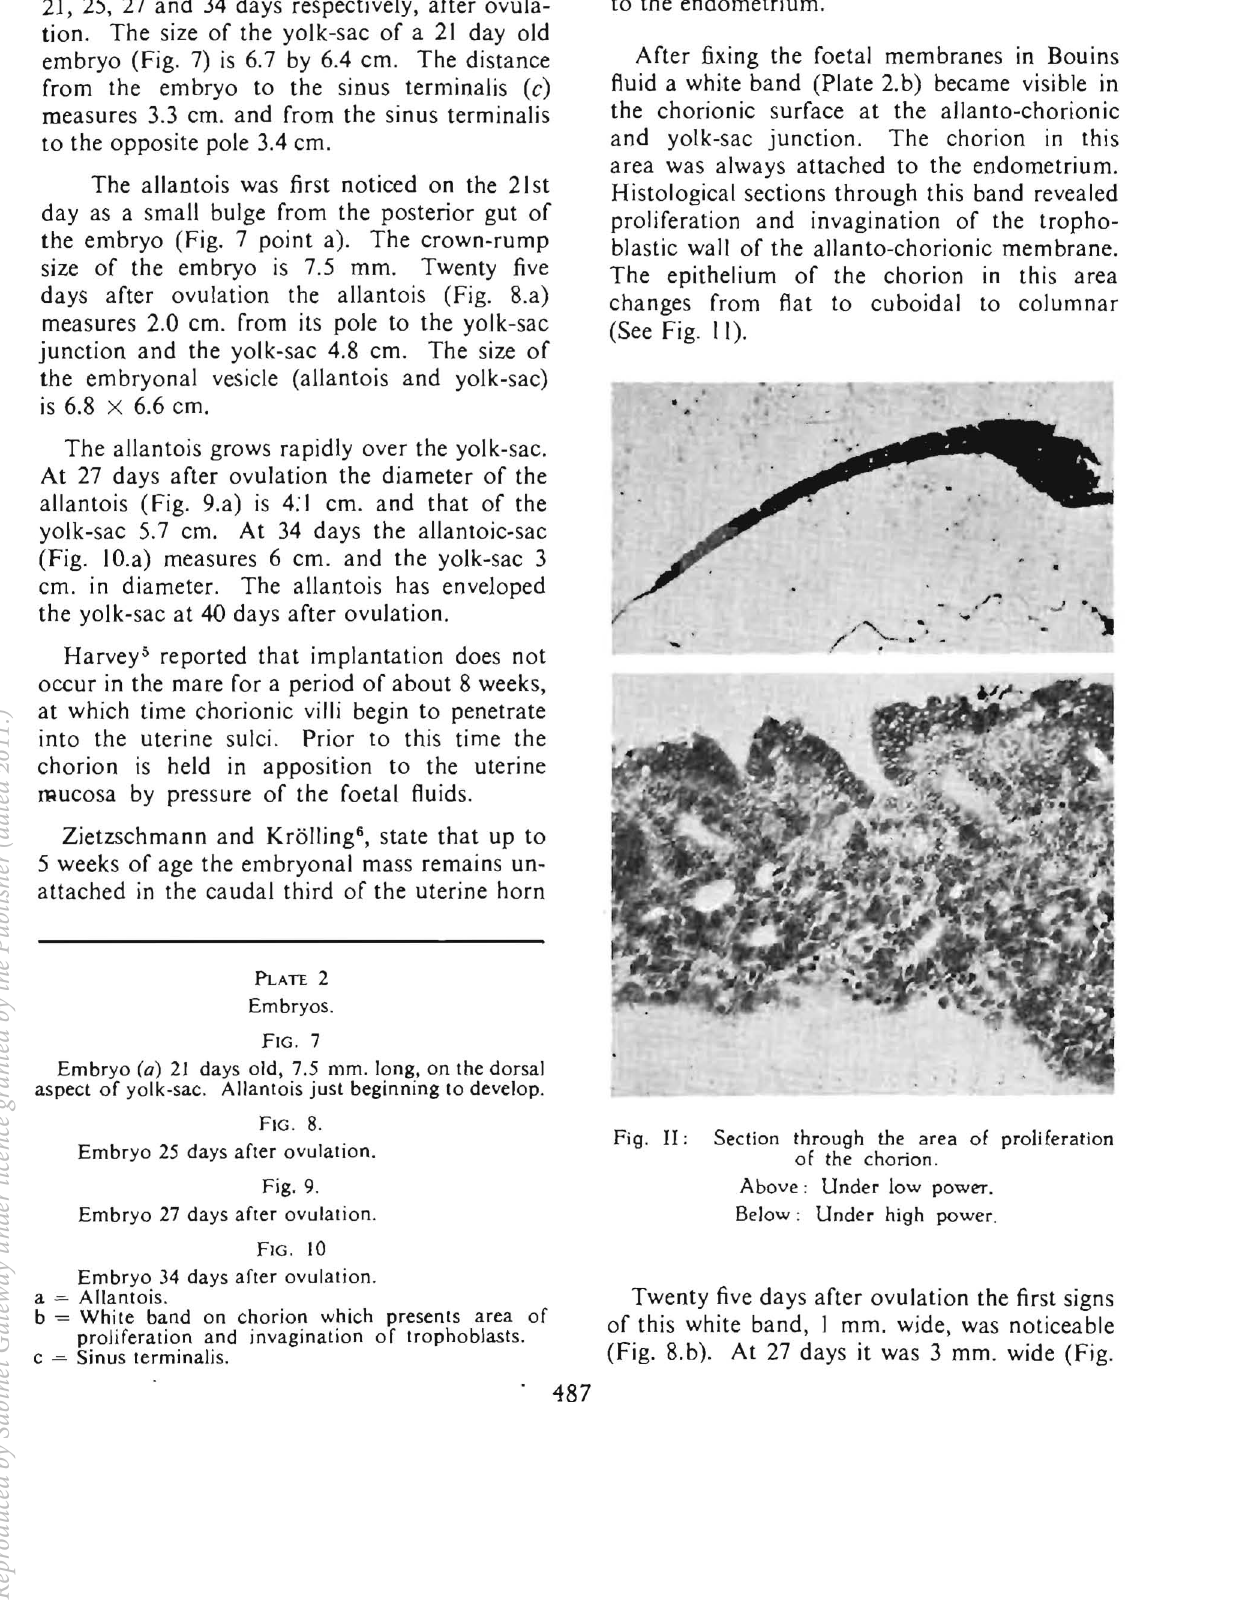
Embryo 25 days after ovulation. Embryo 27 days afrer ovulation. Embryo 34 days after ovulation. a = Allanrois. b = White band on chorion which presents area of proliferation and invagination of trophoblasts. c = Sinus terminalis.